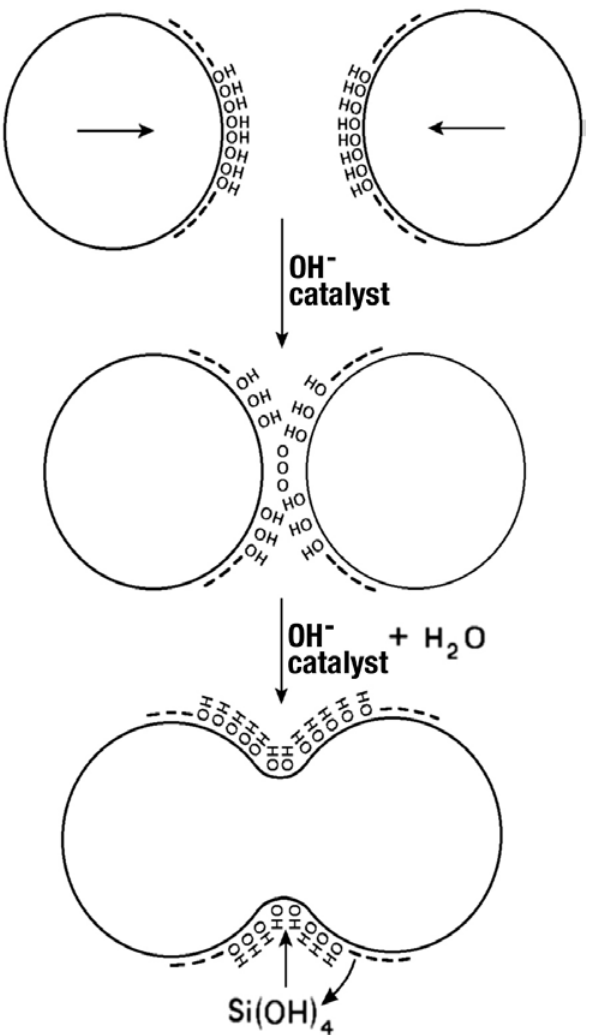
Figure 52. When there is little or no charge repulsion between sili- ca particles such that they can come together to form chains (linked by van der Waals’ attraction), chemical siloxane bonds, catalysed by the presence of hydroxyl ions, also develop as indicated. Once bonded the particles grow together by diffusion and condensation of additional Si(OH) 4 . The resilience and strength of some silica gels is greatly increased when the chains of silica spheres are also chemically linked. [From Iler 2 , 1979, p. 224]